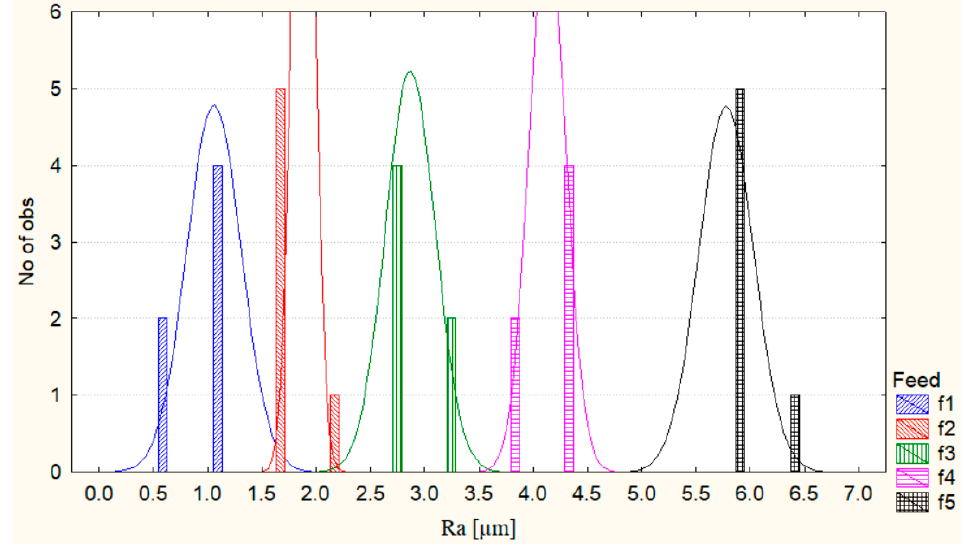
Figure 13. Histograms of R a measurements after pickling.